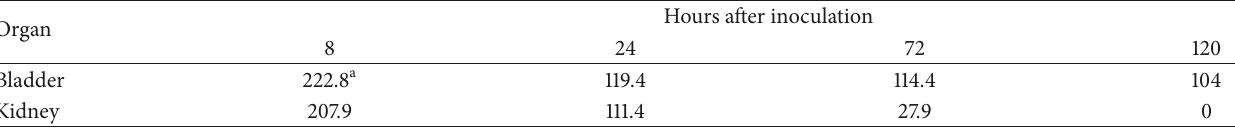
Table 2: Measurement of hemagglutination (HA) titer for UPEC strain NU149 infecting murine bladders and kidneys over a five-day time